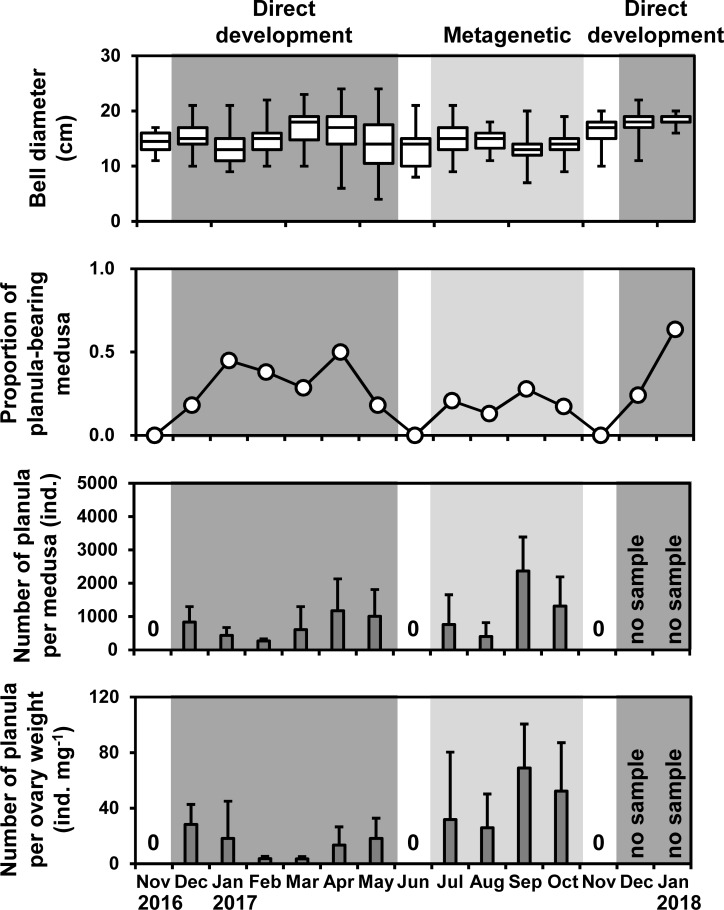
Temporal variations in the bell diameter of medusae, proportion of planula-bearing medusa, and the number of planulae per medusa and per ovary weight.In the top figure, boxes and bars in boxes indicate the first and third quartile and median values, respectively, and bars outside boxes indicate the minimum and maximum values. Bars and error bars in the bottom figure are mean values and SD, respectively. Dark and light shades indicate the direct-development and metagenetic periods, respectively.